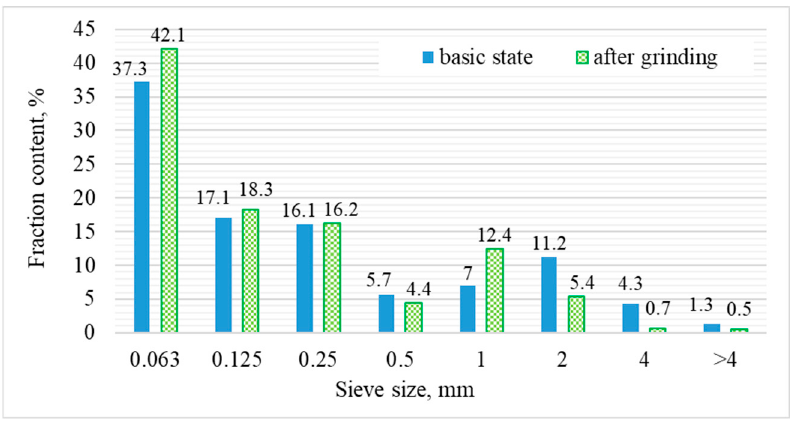
Figure 2. Percentage of the retained FA-S’s fractions in their raw state and after milling.